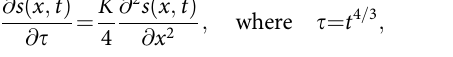
Fig. 3a we compare numerical profiles with the error function, again finding good agreement within accuracy of our simulations. Therefore, the scaling function is, in both cases, D ¼ 1 and D4 1, the error function, the difference being only in the scaling variable which is x / t 2/3 at the super-diffusive isotropic point. This result is surprising, as anomalous diffusion is usually associated with Levy processes and hence long (non-Gaussian) tails in the profiles. Here it seems it all amounts to a nonlinear rescaling of time. Theoretical explanation of this effect is urgent.